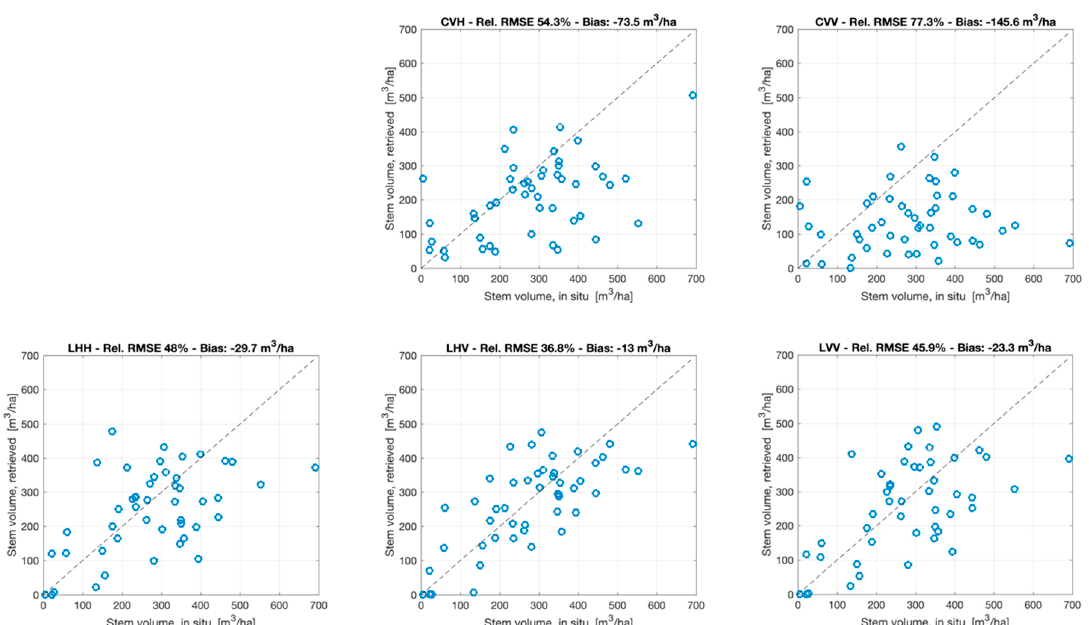
Figure 7. Scatter plots of measured and retrieved stem volume at Remningstorp for a multi-temporal combination of estimates obtained at a given frequency band and polarization.